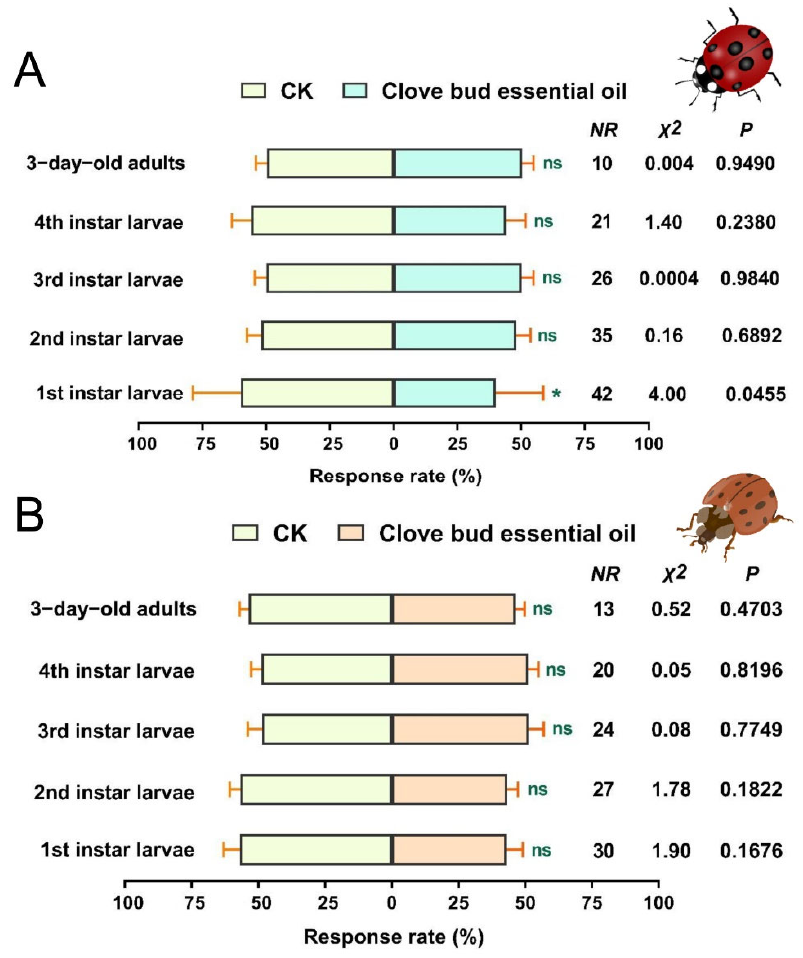
Figure 4. Preferences of Coccinella septempunctata and Harmonia axyridis to CBEO were assessed with a Y ‐ tube olfactometer bioassay. ( A ) Behavioural response of C. septempunctata to 400 μ L/mL of CBEO. ( B ) Behavioural response of H. axyridis to 400 μ L /mL of CBEO. CK represents 5% Tween ‐ 80 treatment. NR (no response) indicates the number of ladybirds that failed to respond within the allotted timeframe. Each bar represents the mean ± SEM of five replicates. Asterisks represent a significant difference in preference (chi ‐ square test, p < 0.05). * p < 0.05, ns = not significant ( p > 0.05).